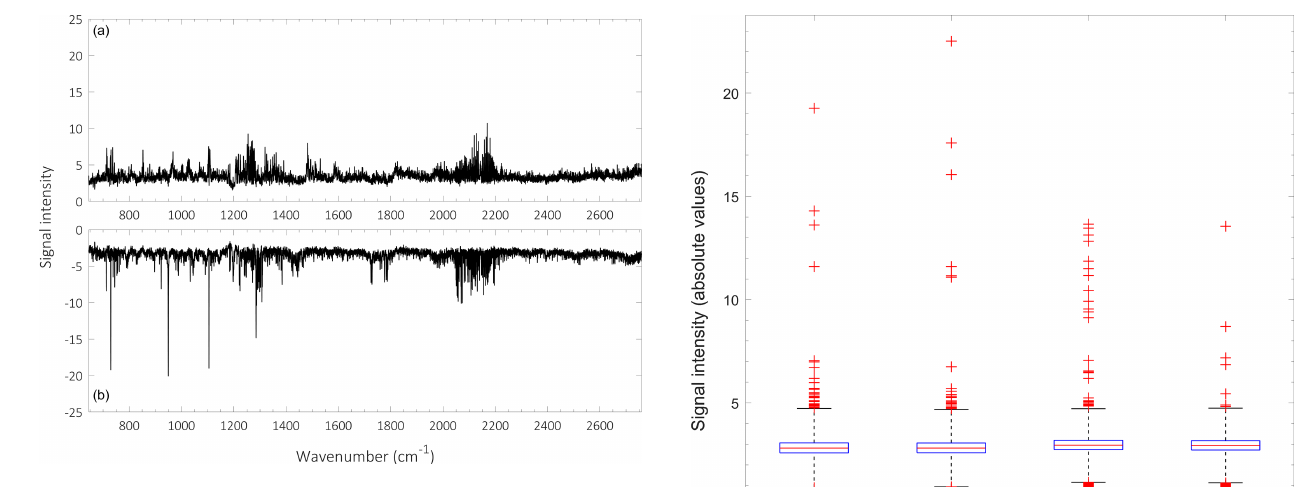
Figure 2. Granule maxima (GMA) (a) and granule min- ima (GMI) (b) pseudo-residuals obtained from a granule of IASI/Metop-B L1C data on 1 January 2020 over Australia.